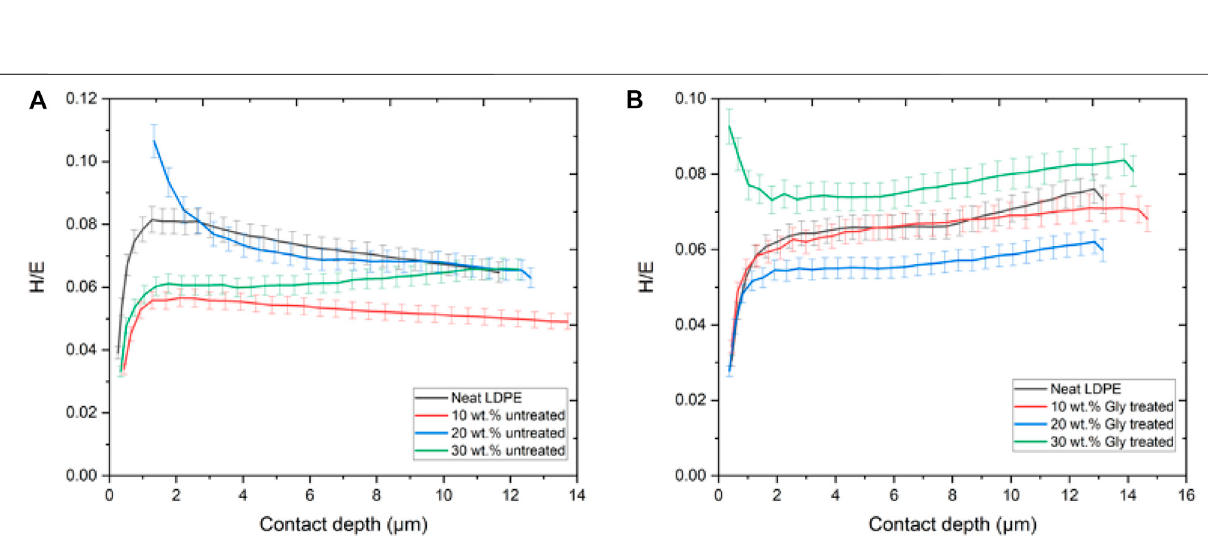
Frontiers in Materials |